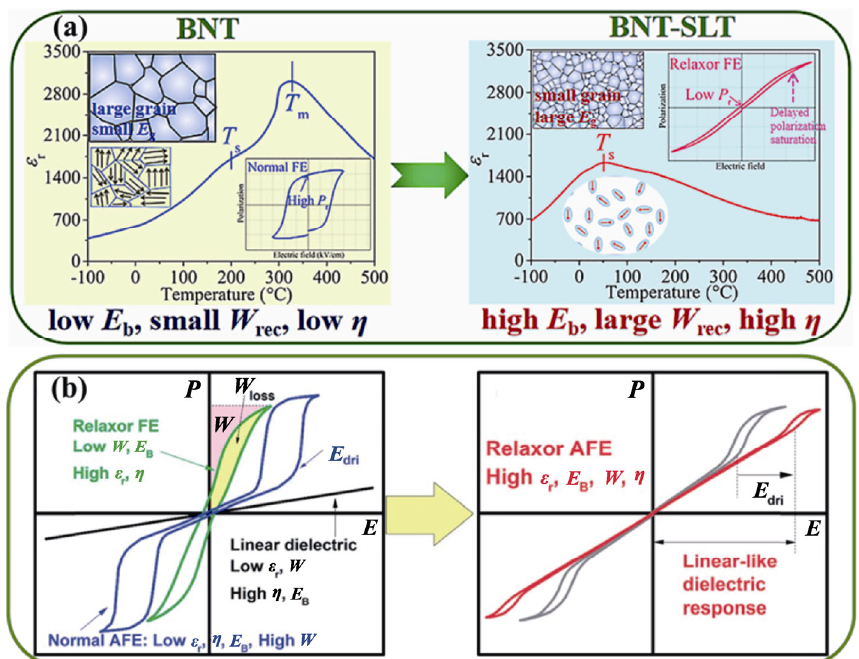
Fig. 11 (a) Schematic diagram for simultaneously achieving large W rec and high η : the E b increased via decreasing grain size and increasing band gap; the relaxation behavior was enhanced by driving T s to room temperature; and the electric field of polarization saturation was delayed by reducing the tolerance factor. Reproduced with permission from Ref. [68], © Elsevier B.V. 2020. (b) Schematic diagram of the energy-storage properties for various types of dielectric ceramics: from the P – E loops for purely linear nonpolar dielectric, relaxor ferroelectric, and normal antiferroelectric ceramics (left), to the P – E loops expected for a relaxor antiferroelectric ceramic (right). Reproduced with permission from Ref. [69], © The Royal Society of Chemistry